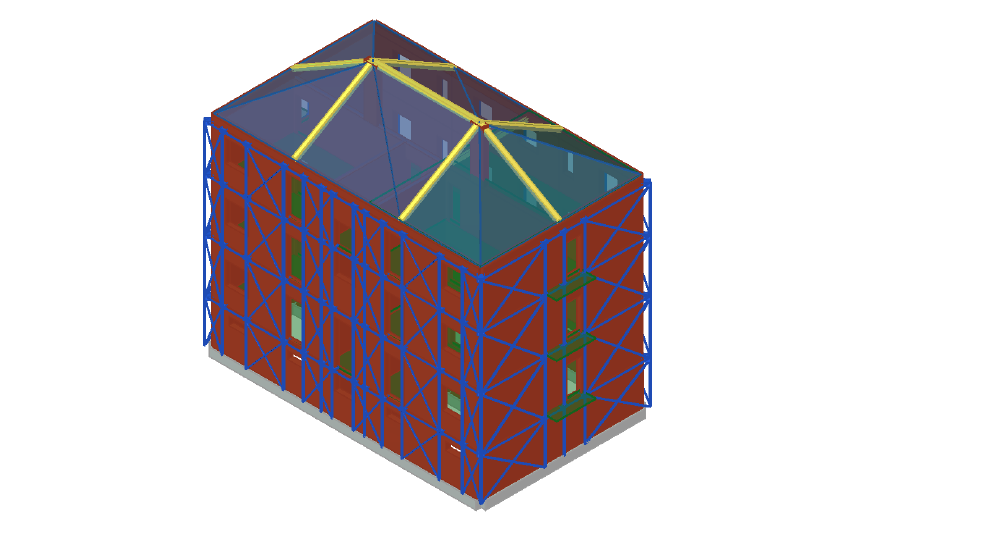
Figure 22. 3D model of the retrofitted structure with the planned coating system. Also in this case, in the first phase, the dynamic analyses referred to the first thirty modal shapes of the structure was performed, as shown in Table 4. Table 4. Dynamic analysis results on the retrofitted building.